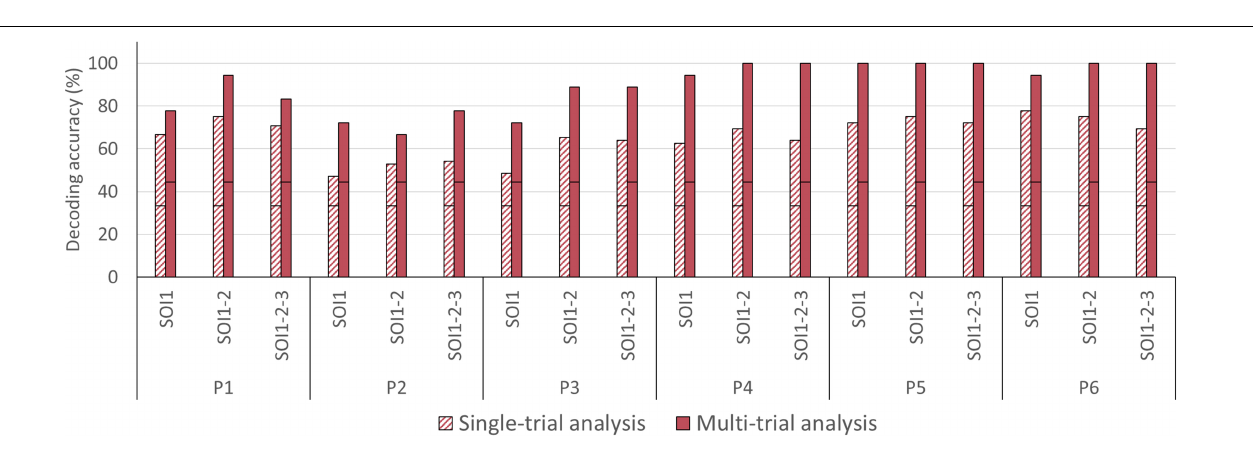
FIGURE 9 | Single- and multi-trial individual decoding accuracies across level of signal averaging. Individual decoding accuracies for the most informative channel-by-chromophore (SOI1), the average of the two most informative channel-by-chromophore (SOI1-2) and the average of the three most informative channel-by-chromophore (SOI1-2-3) obtained with single-trial (striped bars) and multi-trial (solid bars) analysis. The black horizontal stripe within each bar graph represents the chance level for single-trial (33.33%) and multi-trial (44.44%)